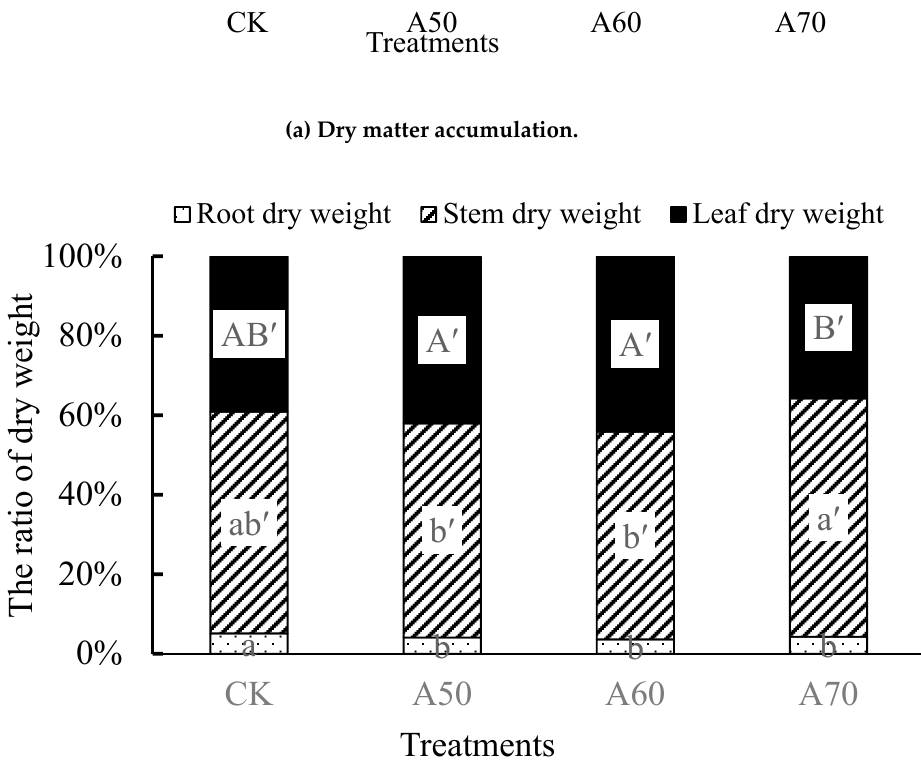
Figure 5. Tomato dry matter accumulation and dry matter proportion in parts of plant under ADI. Note: a(b,c) means significant di ff erence ( p < 0.05) among the root dry weight of di ff erent treatments; a’(b’,c’) means significant di ff erence ( p < 0.05) among the stem dry weight of di ff erent treatments; A’(B’,C’), means significant di ff erence ( p < 0.05) among the leaf dry weight of di ff erent treatments. The di ff erence is according to Duncan test.